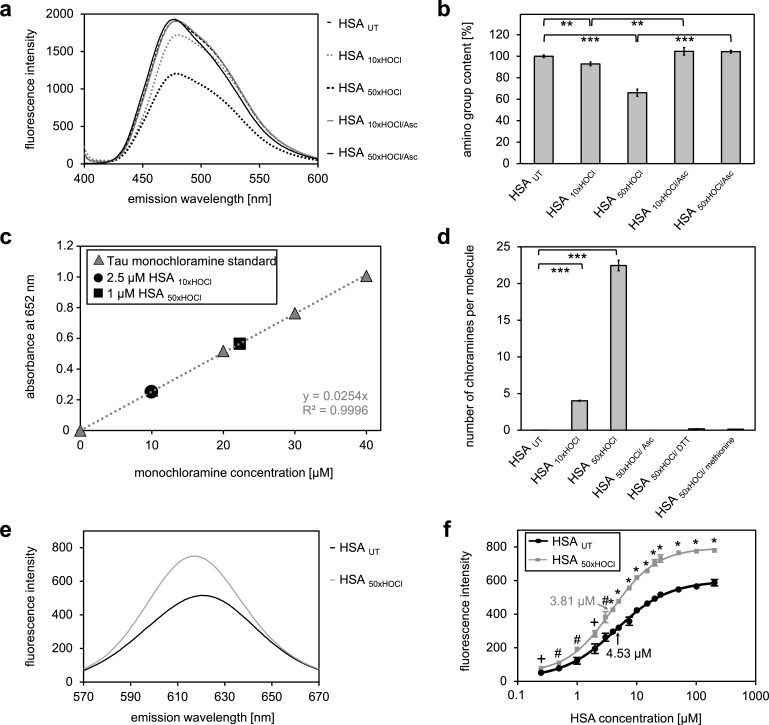
N-chlorination of serum albumin decreases accessible amino group content and increases chloramine content and surface hydrophobicity.(a, b) Amino group content of variously treated HSA was analyzed using fluorescamine. Treatment of HSA with HOCl resulted in a dose-dependent loss of free amino groups. Reduction of chlorinated HSA with ascorbate fully restored the free amino group content. (c) Chloramine content of HSA treated with 10- or 50-fold molar excess of HOCl. Chloramines were determined in 2.5 µM HSA treated with a 10-fold excess of HOCl and 1 µM HSA treated with a 50-fold excess and compared to a standard curve generated with known quantities of taurine N-chloramine. (d) Quantified chloramine content in HSA treated with a 10- and 50-fold excess of HOCl. (e) Fluorescence of 1.6 μM Nile red in the presence of native HSA or HSA, that has been treated with a 50-fold molar excess of HOCl. An increased absolute fluorescence and a shift in maximum emission wavelength (from 621.5 nm to 616.5 nm) can be observed for HSA 50xHOCl. (f) Absolute fluorescence of Nile red measured at the emission maximum at 621.5 nm and 616.5 nm, respectively, was plotted against the corresponding HSA UT and HSA 50xHOCl concentrations, respectively. The average concentrations, at which HSA UT and HSA 50xHOCl have been half-saturated with Nile red are marked by arrows. Means and standard deviations in b, d, and f are based on three independent experiments. (b and d) Student’s t-test: *p<0.05, **p<0.01, ***p<0.001. (f) Student’s t-test:+p < 0.05, #p<0.01, *p<0.001. For a, c, and d representative measurements are shown.
10.7554/eLife.47395.021Figure 3—source data 1.Numerical fluorescence spectroscopy data obtained during determination of free amino groups represented in Figure 3a and b.

10.7554/eLife.47395.022Figure 3—source data 2.Numerical fluorescence spectroscopy data obtained during determination of protein chloramines represented in Figure 3c.

10.7554/eLife.47395.023Figure 3—source data 3.Numerical fluorescence spectroscopy data obtained during determination of protein chloramines represented in Figure 3d.

10.7554/eLife.47395.024Figure 3—source data 4.Numerical fluorescence spectroscopy data obtained during determination of protein hydrophobicity represented in Figure 3e.

10.7554/eLife.47395.025Figure 3—source data 5.Numerical fluorescence spectroscopy intensity data obtained during determination of protein hydrophobicity represented in Figure 3f.